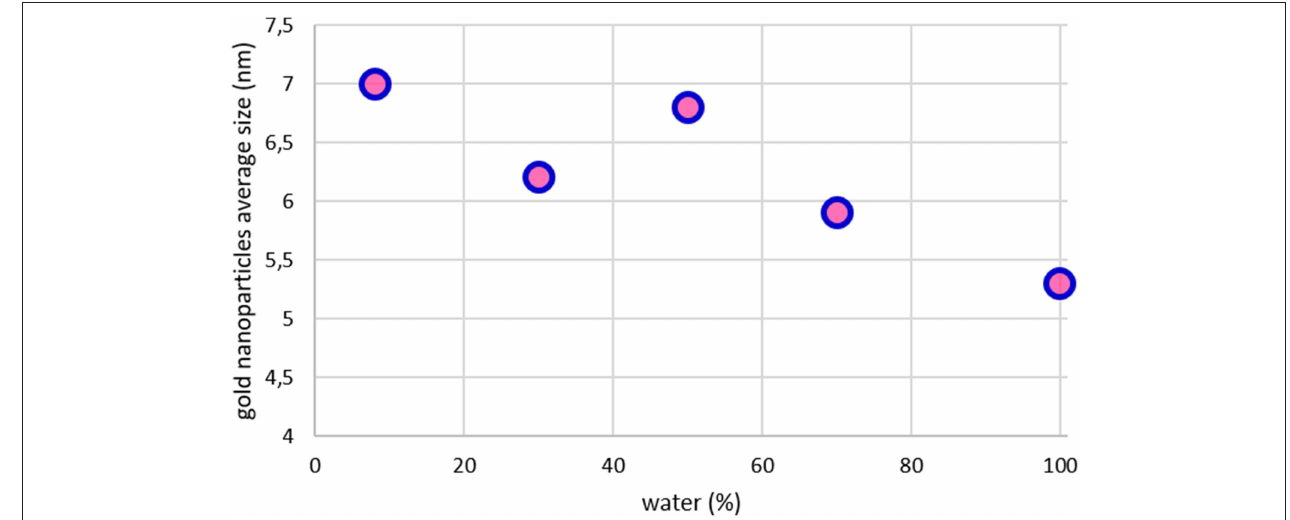
FIGURE 6 | Relationship of the gold average particle size with the water percentage of the